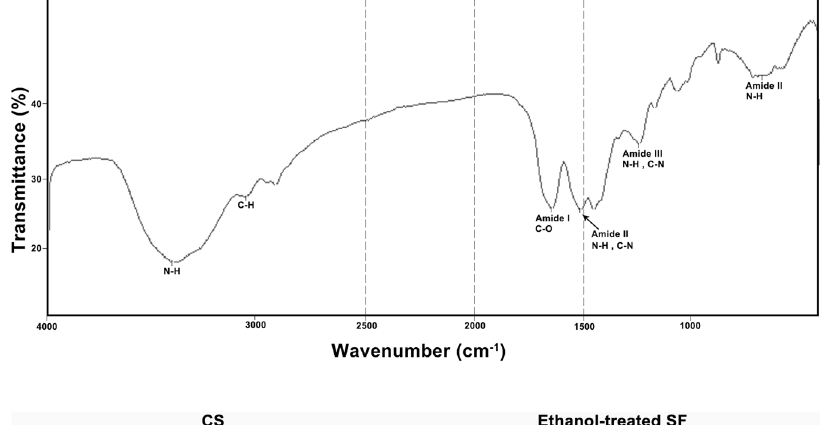
Fig. 2 The ultrastructure of the electrospun CS and electrospun SF after treating with ethanol observed under SEM